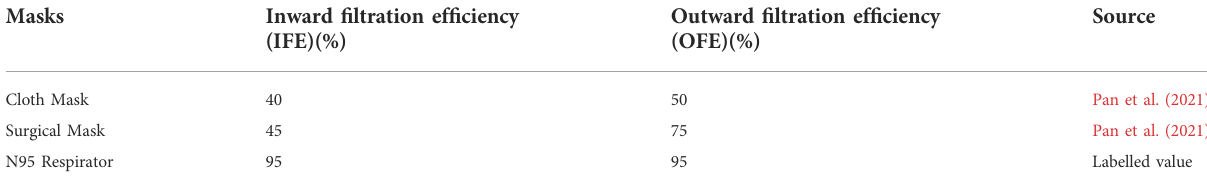
TABLE 2 Mask fi ltration ef fi ciencies for particles of 2 µm by mask